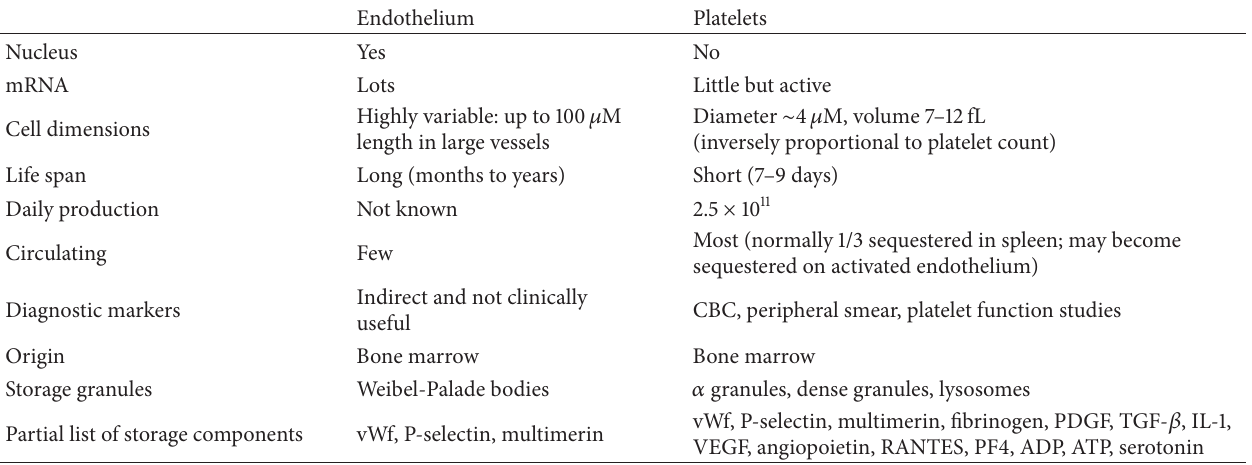
Table 2: A comparison of endothelial and platelet properties (adapted from Warkentin et al., 2003